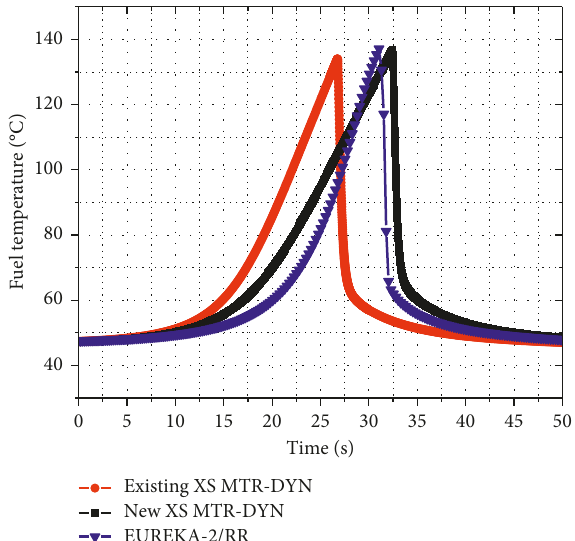
Figure 17: Fuel temperature during RIA transient at initial power of 1MW. Table 4: Maximum temperature of coolant, cladding, and fuel element during RIA transient at initial power of 1MW. Parameters Existing XS